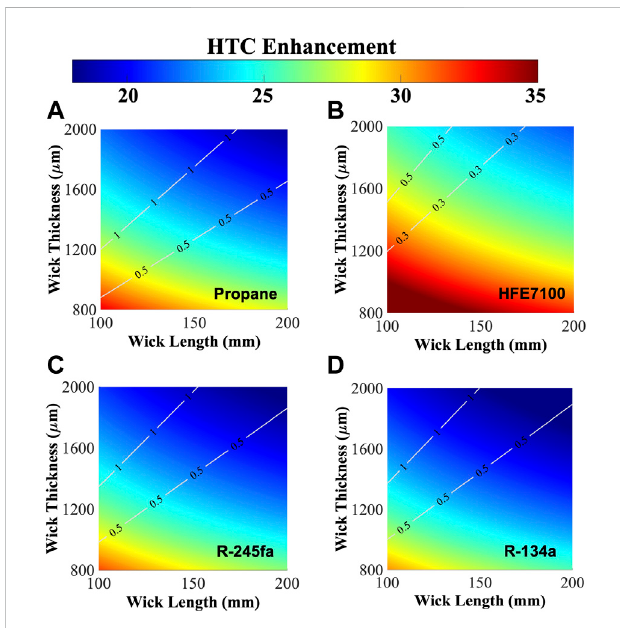
Regimemapspredictingcondensation HTCEnhancementwiththe pillararrayfor (A) propane, (B) HFE7100, (C) R-245fa,and (D) R-134a.The pillar dimensions are d = 200 μ m, l = 600 μ m, and the condensate temperature is 30 °